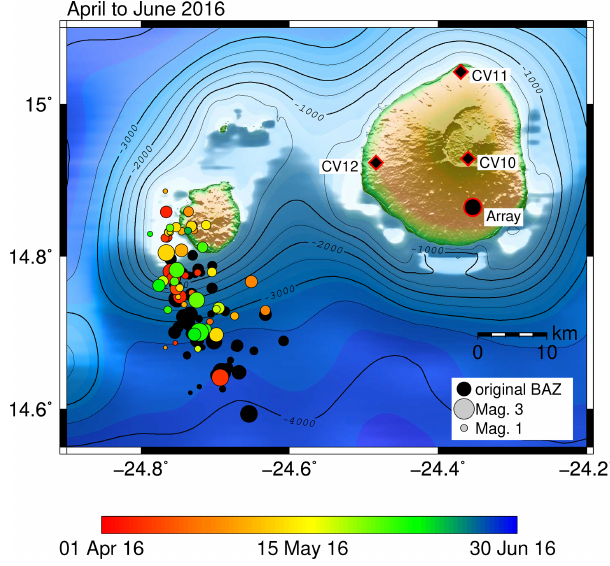
Figure 6. Earthquake locations from April to June 2016. From April to June 2016 the southernmost array station was out of operation. Comparison of events recorded in other time periods shows that the outage of this station leads to a bias of about 8.9 ◦ in backaz- imuth towards the south. Original locations of the earthquakes are marked by black symbols; the corrected locations (with a mean cor- rection of 8.9 ◦ in the backazimuth determination) are marked by coloured symbols. Topographic and bathymetry data are from Ryan et al.